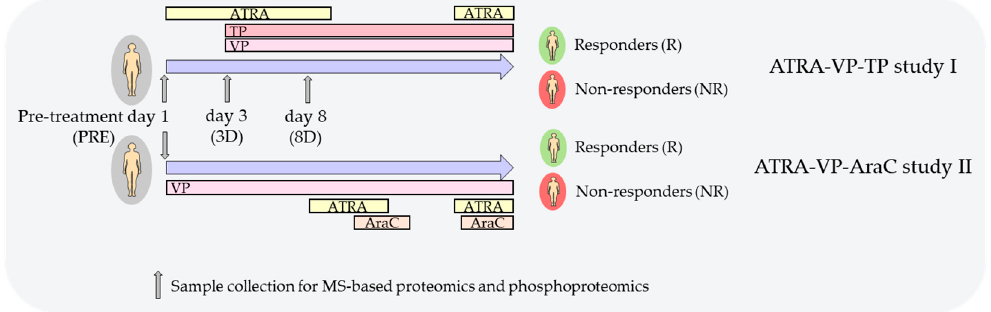
Figure 1. Overview of the two all-trans retinoic acid (ATRA)-valproic acid (VP)-based studies used in this manuscript [4,6]. Samples were collected before any treatment from both studies and were classified as responders (PRE-R) or non-responders (PRE-NR) according to the patient’s response at the end of the treatments. Samples from patients treated only with ATRA and with VP and theophylline (TP) afterwards were collected at day 3 (3D-R, 3D-NR) and at day 8 (8D-R, 8D-NR), respectively, in the ATRA–VP–TP study. All the time points for sample collection for further mass spectrometry (MS)-based proteomics and phosphoproteomics analyses are indicated with a grey arrow. The length of the lilac arrows does not correspond with the real treatments’ timing. The characteristics of both studies are detailed in Materials and Methods.